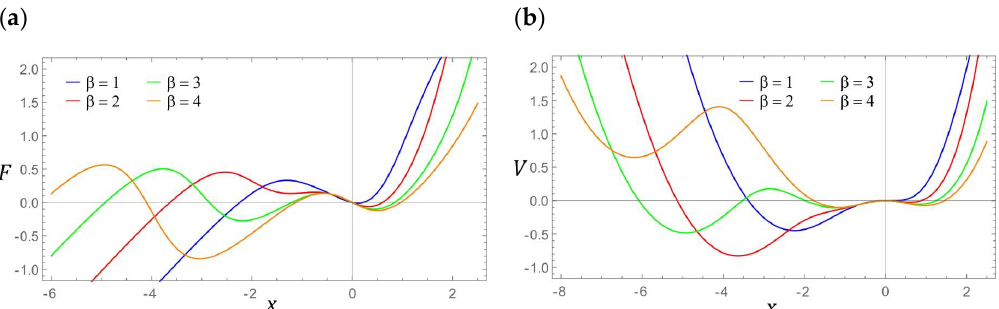
Figure 3. Two-dimensional images: ( a ) mechanical characteristics, F ( x ), ( b ) potential shape with a barrier, V ( x ) for various geometrical factors, β .